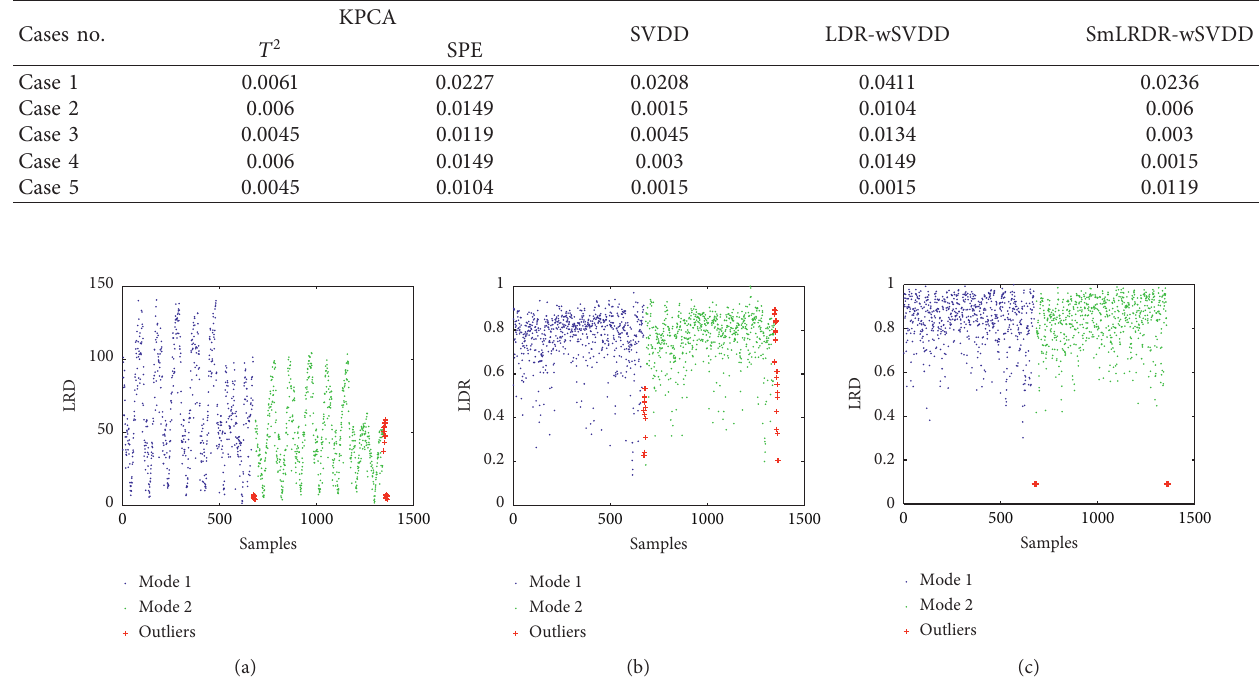
Table 9: FAR under five cases on